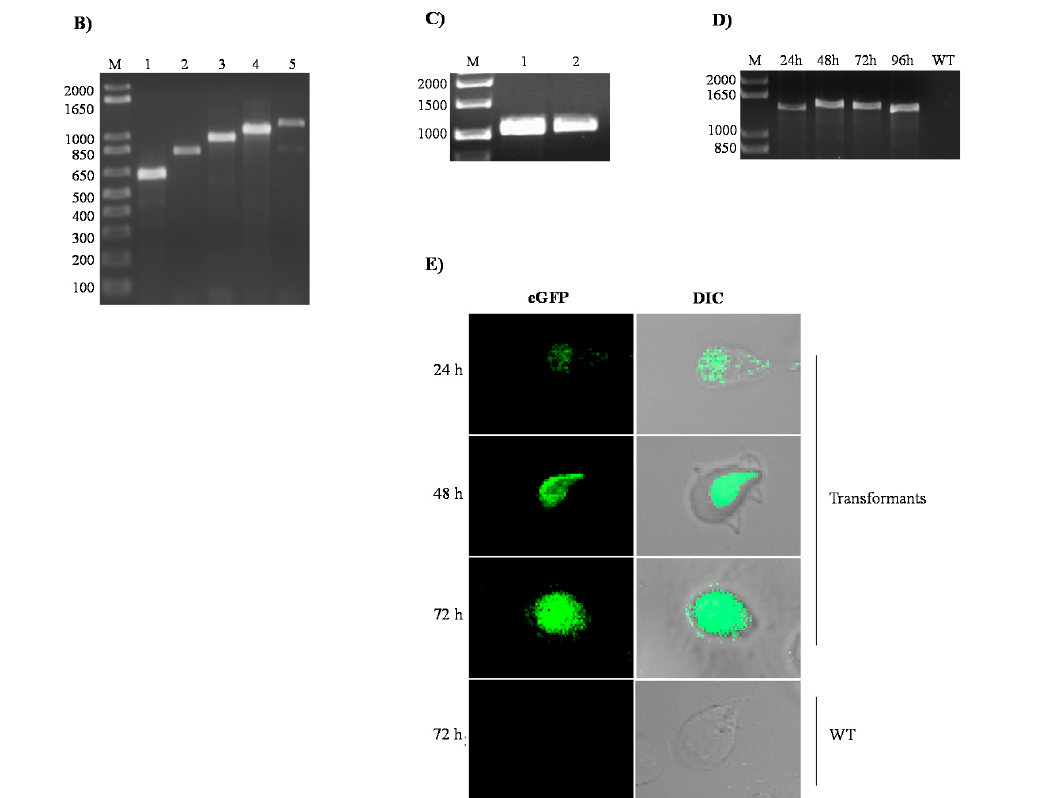
Figure 2. Analysis of Giardia trophozoites transformed with the p TubGdh _eGFP-RNAi derived plasmids for the presence of elements of the vector and eGFP gene expression ability. ( A ) Linearized p TubGdh _eGFP-RNAi vector showing the α 2-Tub :: gdh and the δ -Gia ::eGFP cassettes for dsRNA synthesis and eGFP gene expression, respectively, and the position of primers used for PCR with the expected amplicon sizes. ( B ) Electrophoresis gel of the PCR amplification products obtained from transformants with different fragments of the NADHox gene inserted at the α 2 - Tub :: gdh cassette; lane 1: